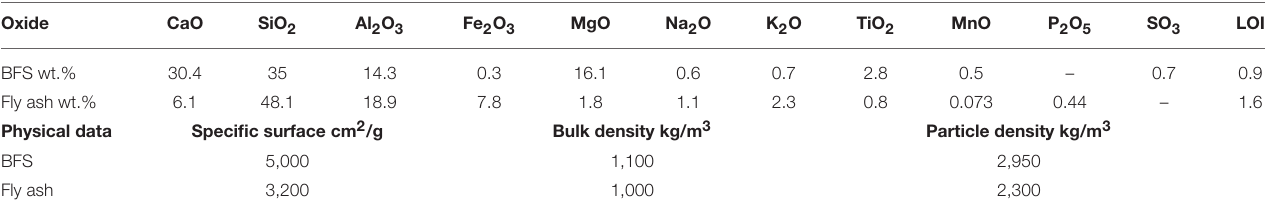
TABLE 1 | Chemical composition and physical properties of BFS and fly ash used in this work, measured by X-ray fluorescence, and represented as oxides. Oxide